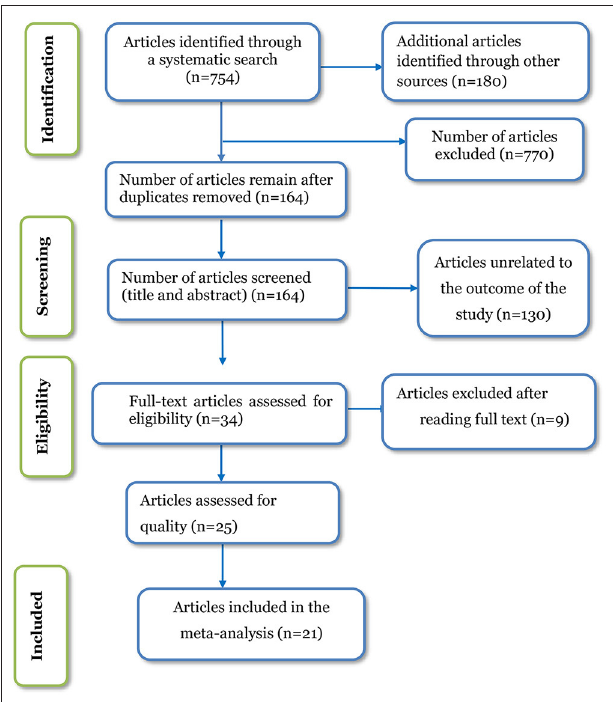
FIGURE 1 | PRISMA flow diagram of included studies in the systematic review and meta-analysis of episiotomy practice and its associated factors in Africa,